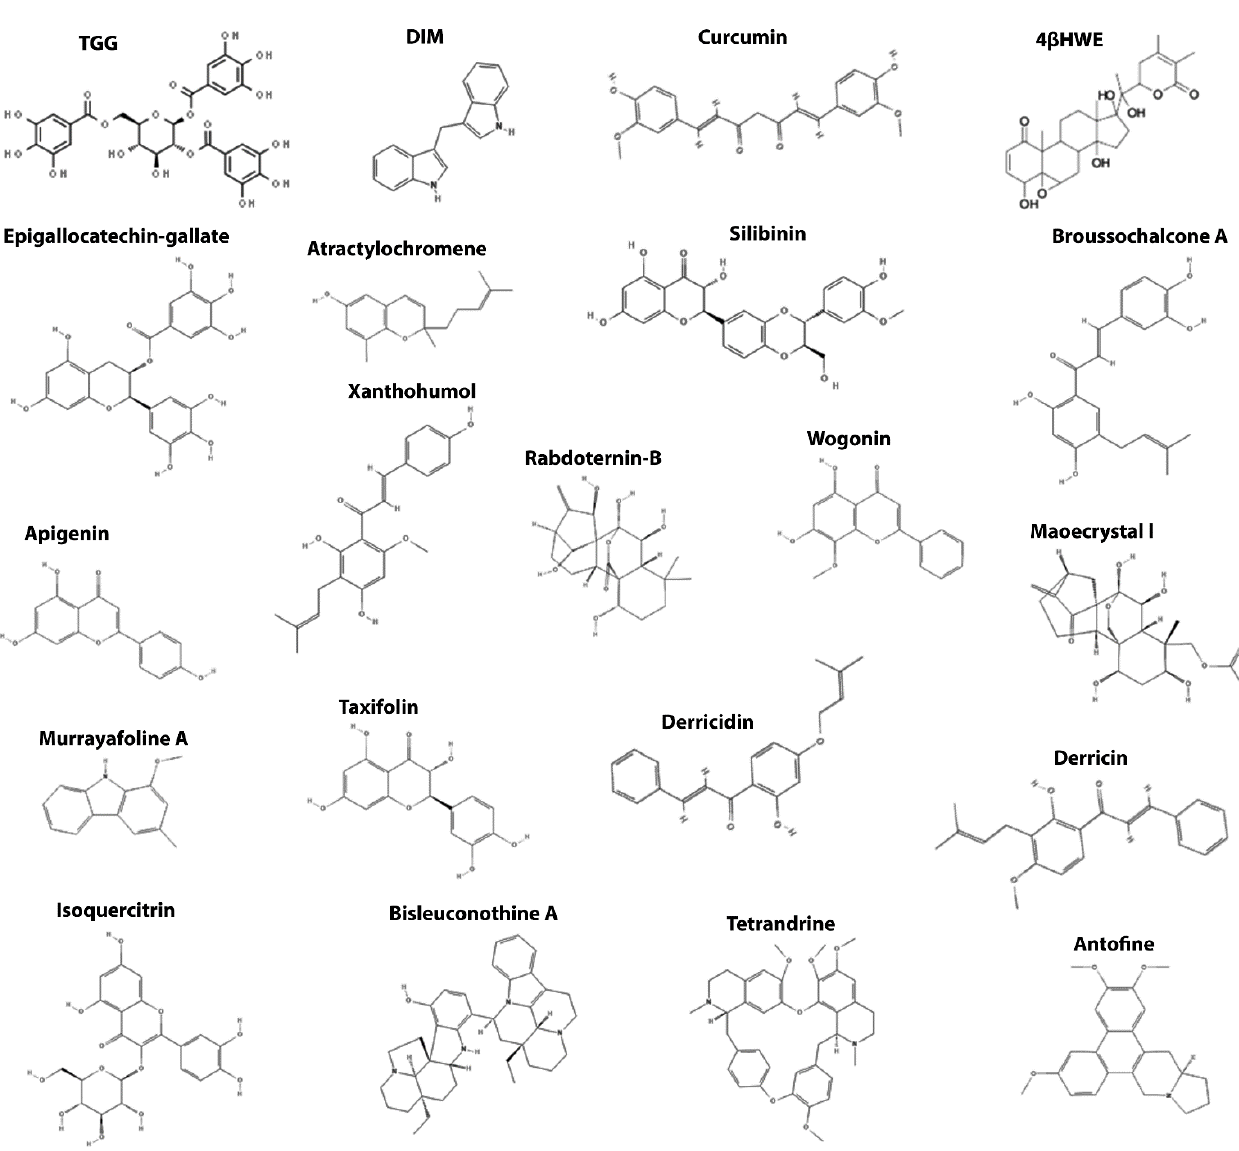
Figure 5. Chemical structures from the naturally occurring small molecules that target the β-catenin protein in the Wnt/β-catenin signaling pathway. protein in the Wnt/ β -catenin signaling